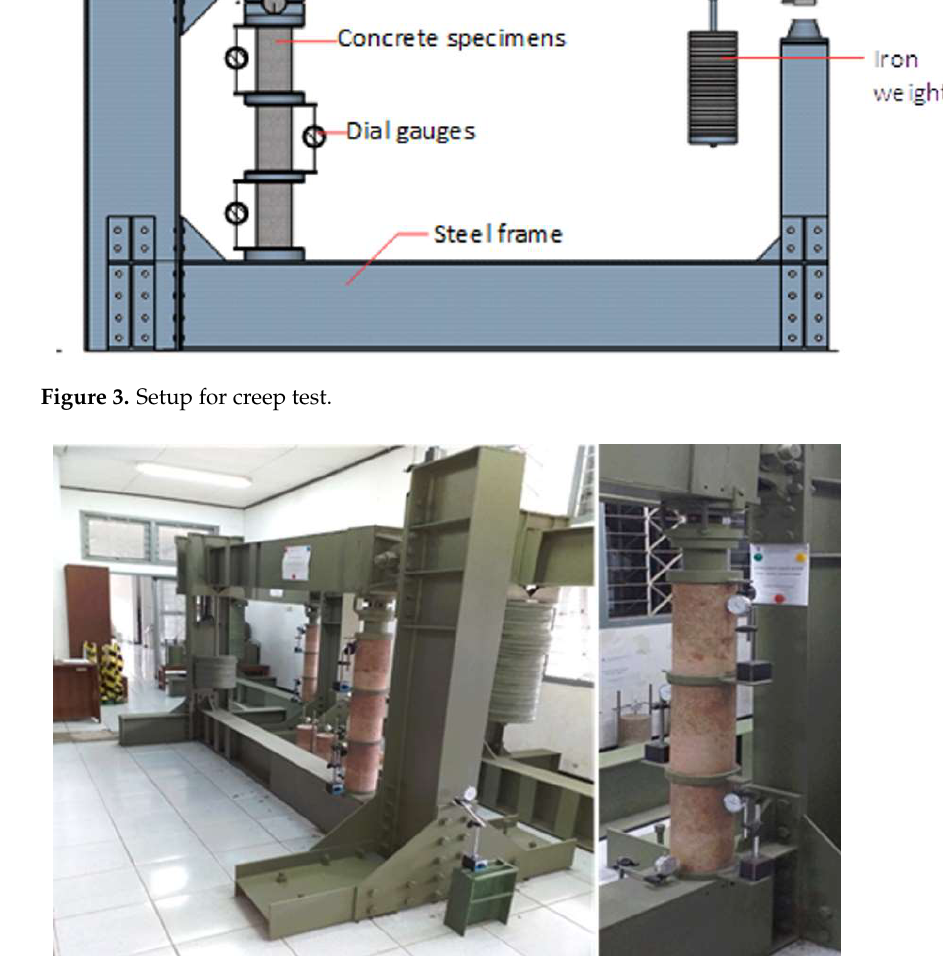
Figure 4. Displacement measurements of concrete creep.